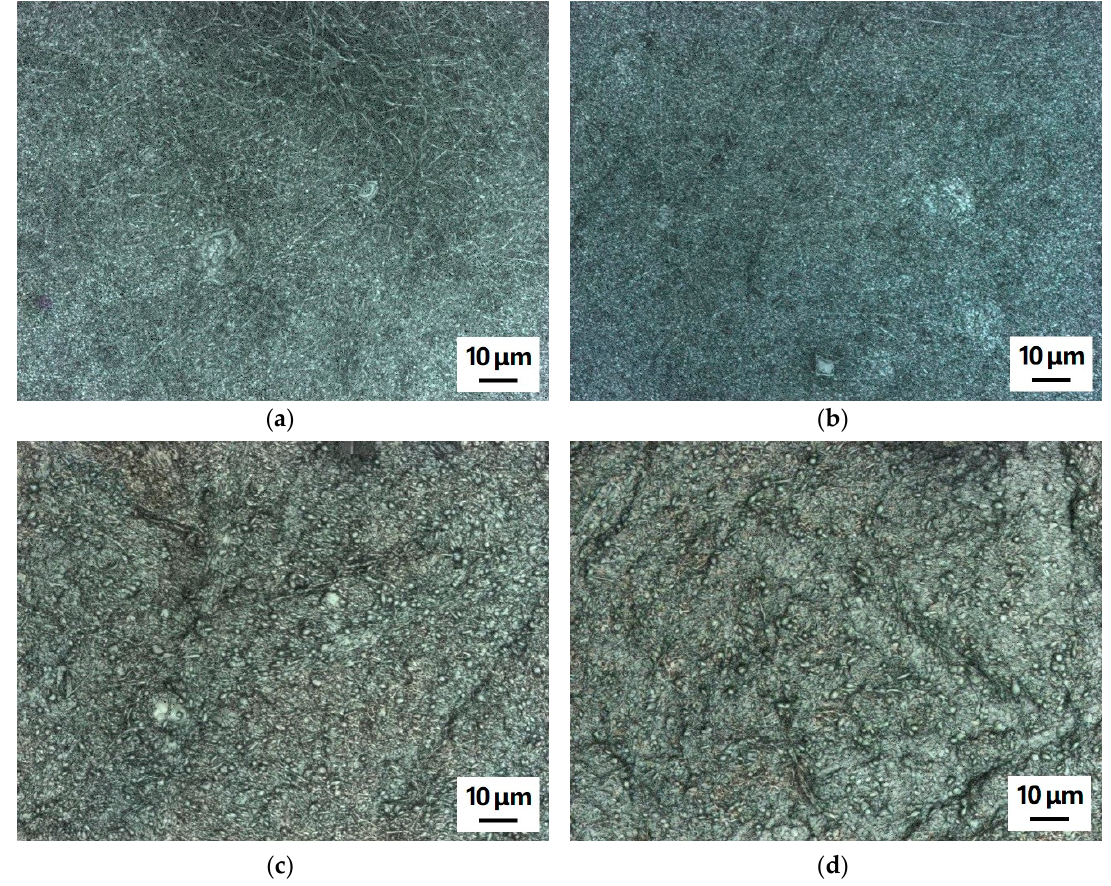
Figure 4. Confocal laser scanning microscope (CLSM) images of polyacrylonitrile (PAN) nanofiber mats: ( a ) pure PAN (electrospun with 80 kV), ( b ) pure PAN (electrospun with 80 kV) after printing on the other side of the nanofiber mat, ( c ) carbonized PAN (electrospun with 50 kV), and ( d ) carbonized PAN (electrospun with 50 kV) after printing on the other side of the nanofiber mat.